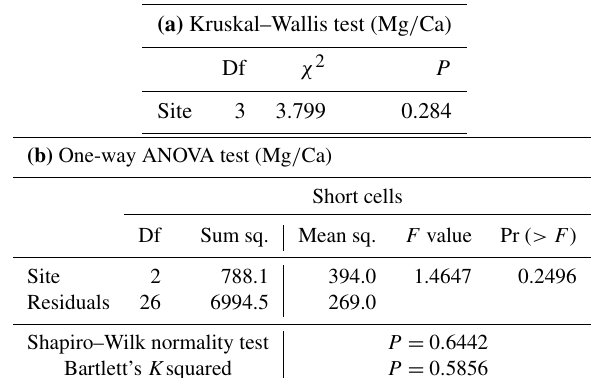
Table A1. (a) Statistically non-significant results of tests performed to evaluate (a) the differences of Mg / Ca in L. corallioides and (b) the differences of Mg / Ca in the short cells of L. corallioides collected at different sampling sites. Test significance at α = 0 .